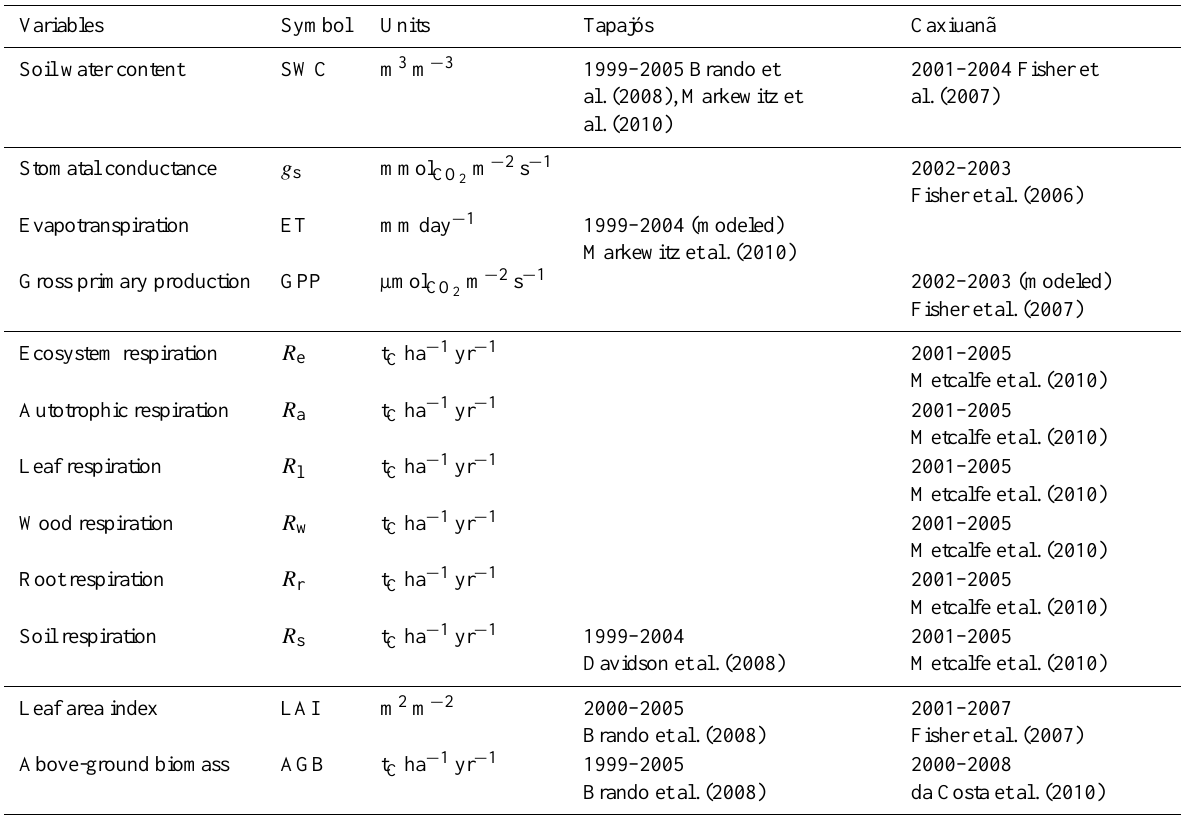
Table 3. References and available period for observations used in this study.